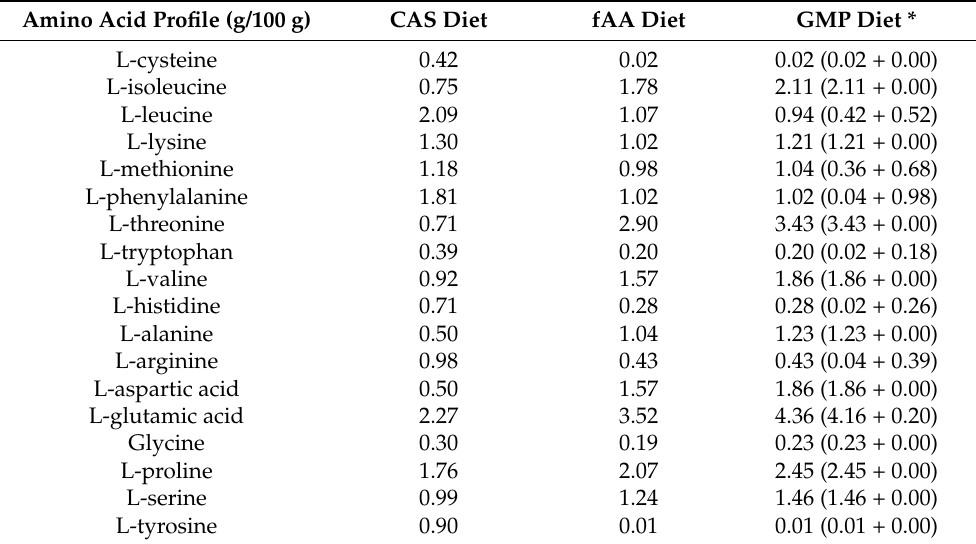
Table 3. Amino acid profile of the control diet (CAS diet) and the experimental diets (fAA diet and GMP diet).